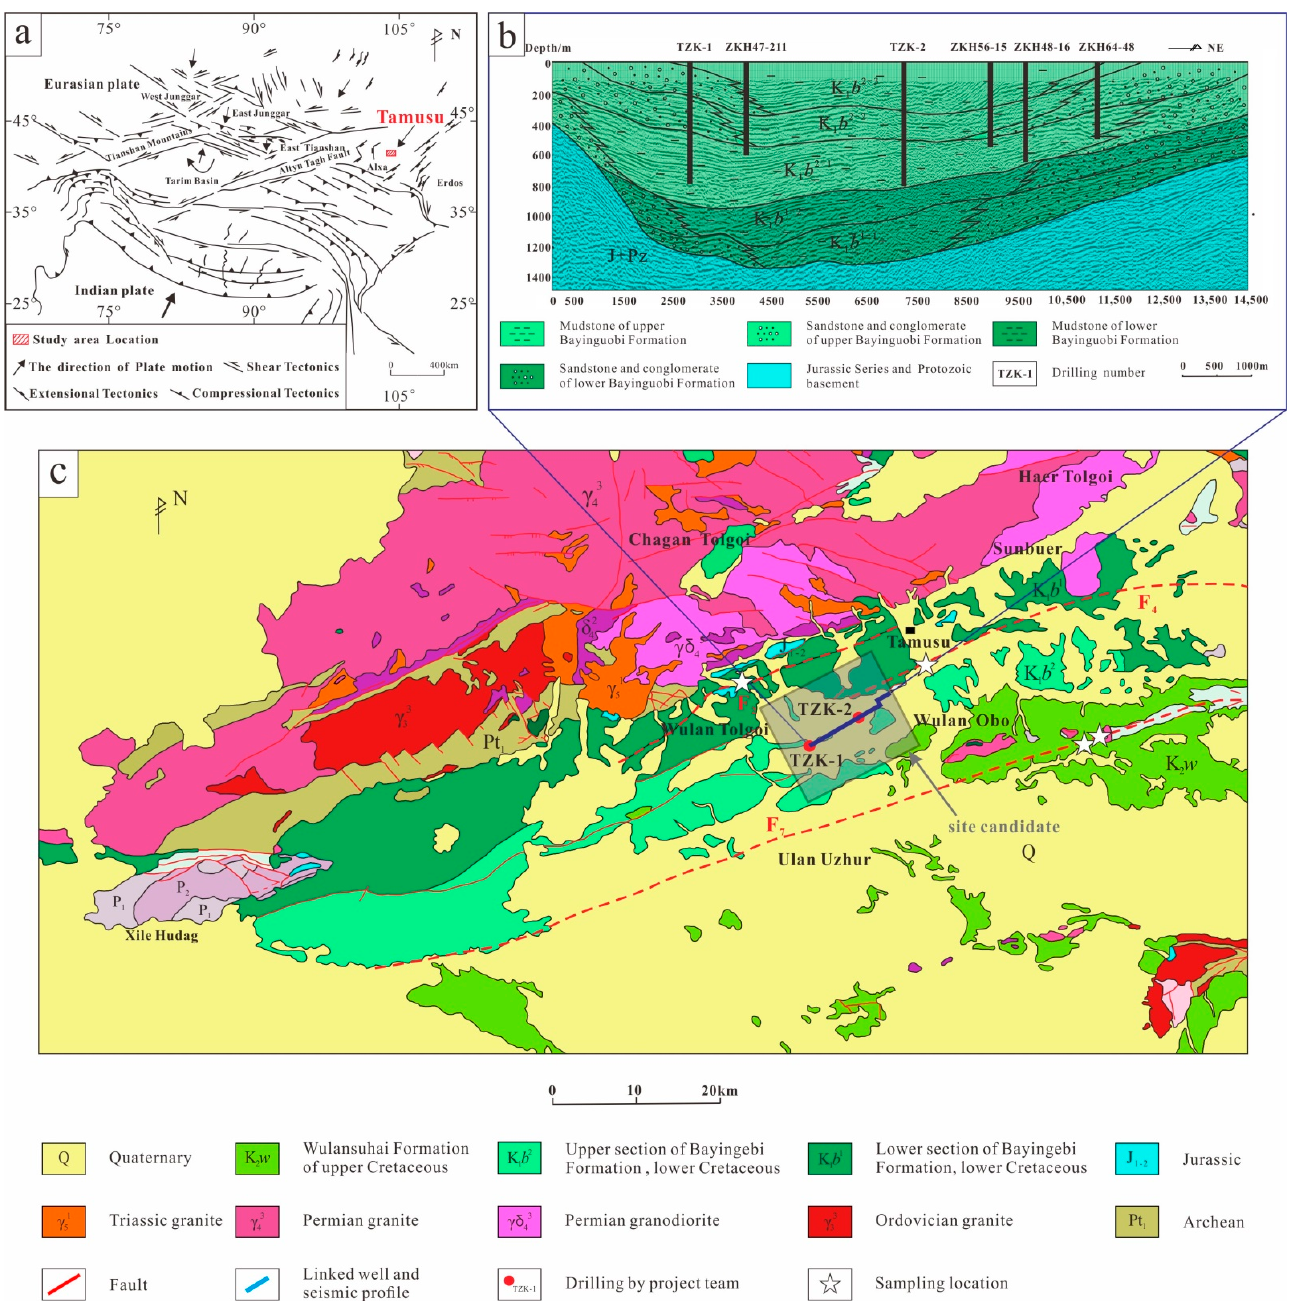
Figure 1. Deformation system of the Tibetan plateau type in west China and tectonic system map of Tamusu area. ( a ) shows the deformation system of Qinghai-Tibet Plateau in Western China, in which the red square shows the location of Tamusu study area; ( b ) is a near East-West holes-seismic profile in the candidate in ( c ); ( c ) shows the geological map of Tamusu study area.